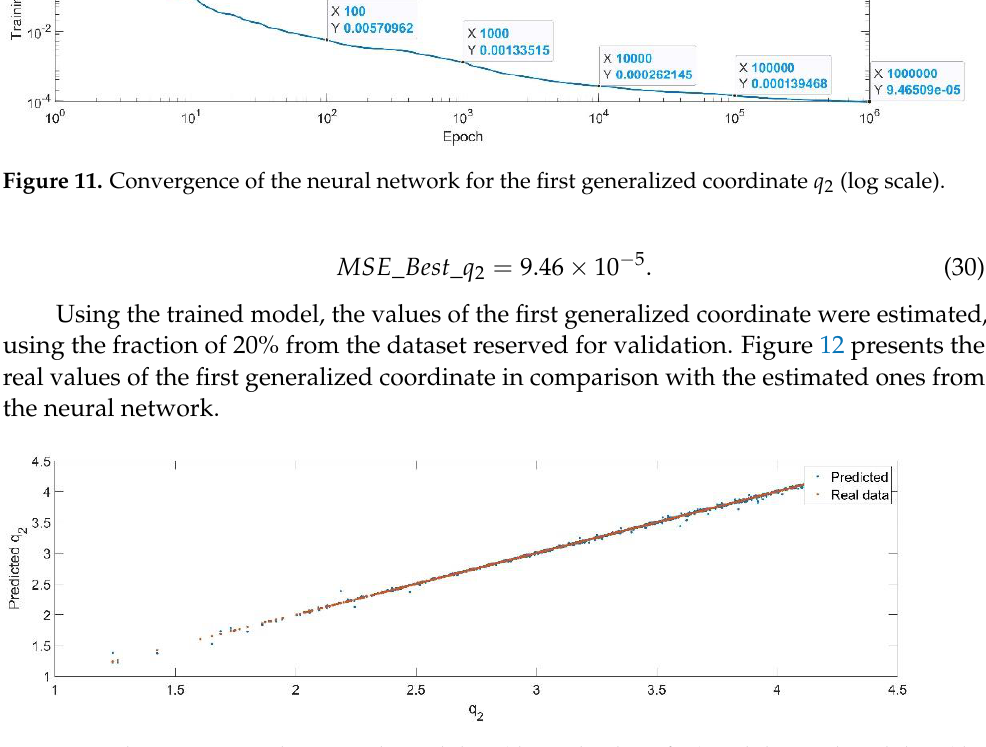
Figure 12. The comparison between the real data (the real value of 𝑞 2 ) and the predicted data (the predicted value of 𝑞 2 ).